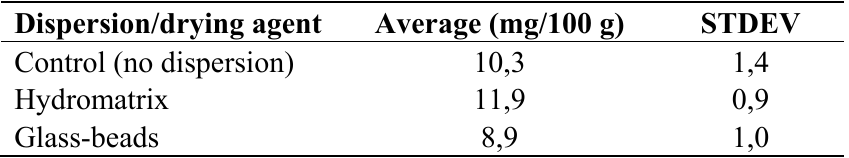
Table 3. Effect of using different types of dispersion/drying agents on the yield of β -carotenes in fresh orange carrots. Samples were extracted with ethanol at 60  C for 5 times 2 min (10 min in